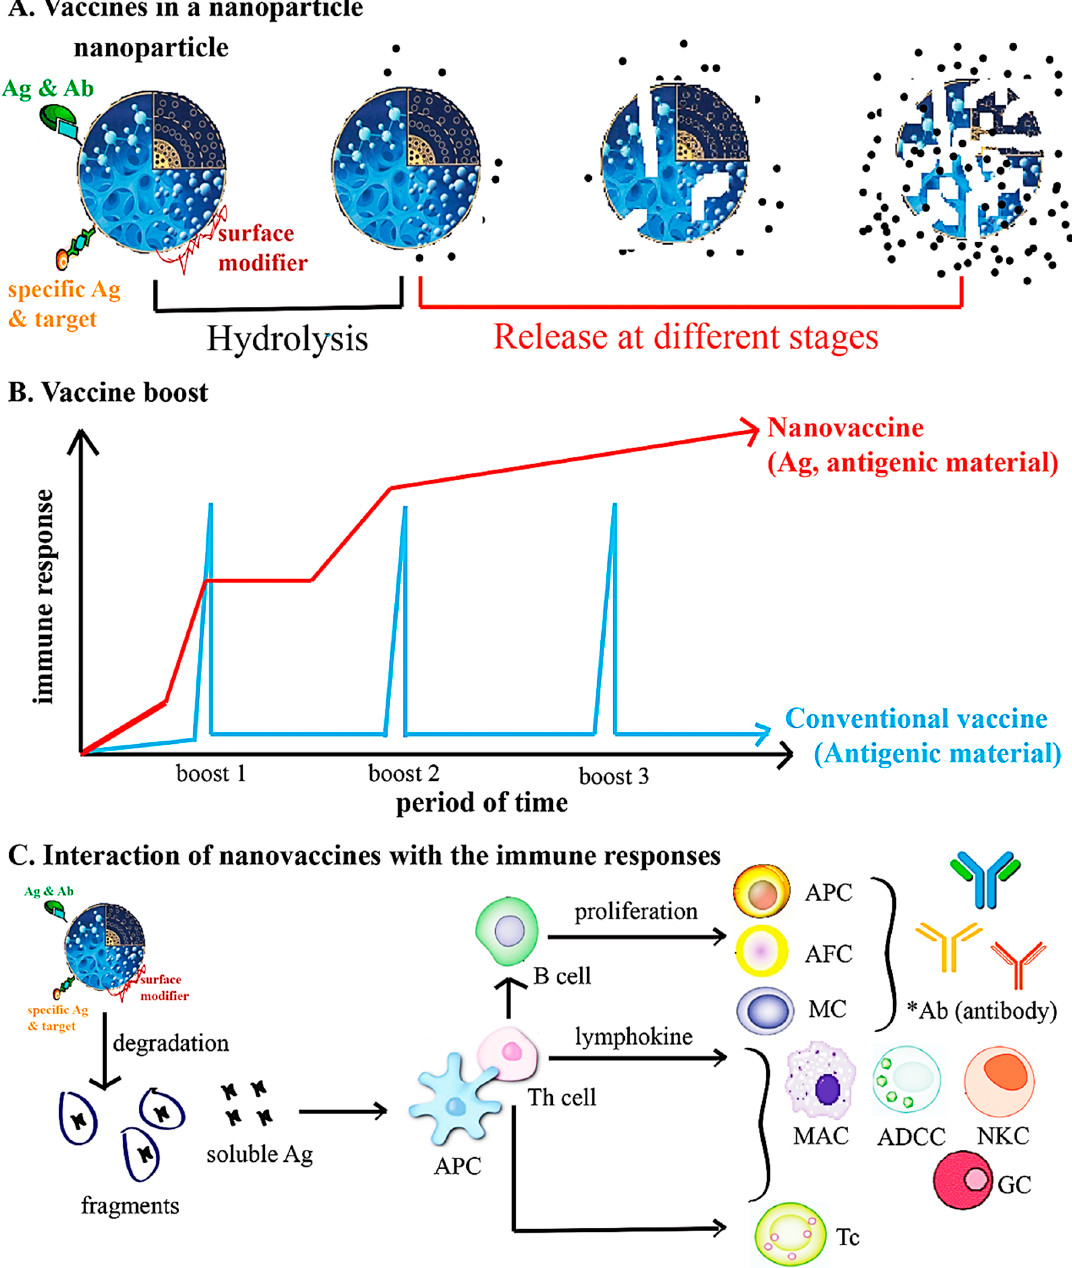
Figure 7. Nanotechnologies utilized in nanomedicine vaccines. Ag (antigen); Ab (antibody); APC (antigen presenting cell); IgG (serum immunoglobulin G); AFC (antibody forming cell); ADCC (antibody-dependent cytotoxic cell); Tc (cytotoxic T-cell); GC (granulocyte); Th (helper T-cell); MAC (macrophage); MC (memory cell); NKC (natural killer cell). Reproduced with permission from [24], (CC BY). Table 4. Some important examples of NP-based vaccine candidates against CoVs. Type of NPs Adjuvant Findings Refs. CoVs Acceleration of the peritoneal macrophages [84] Swine TGEV Gold NPs Gold NPs respiratory activity and plasma IFN- γ level SARS-CoV Gold NPs Gold NPs Stimulation of IgG response [50]